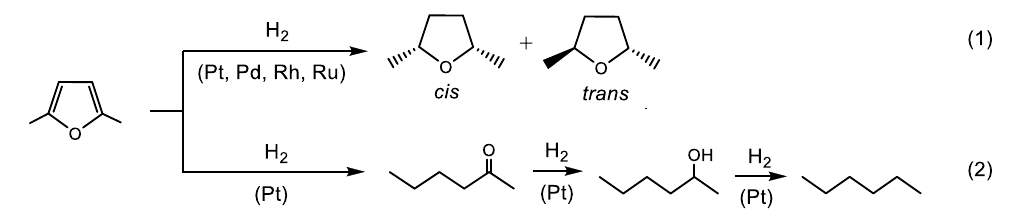
Scheme 1. Reaction network for hydroconversion of DMF catalysed by noble metals.